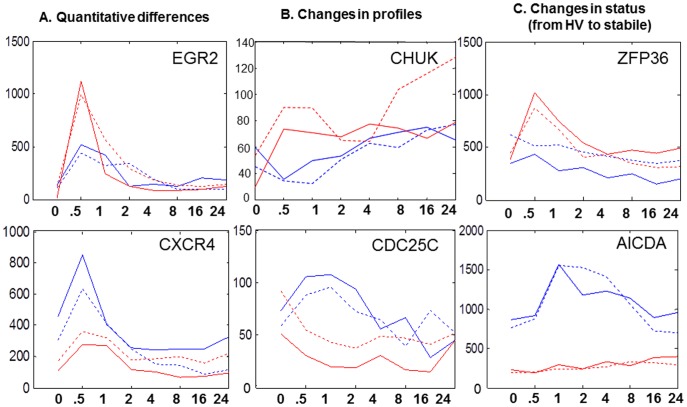
Differences in gene dynamics between normal control SLE samples.The shown profiles are representative of gene dynamics observed in duplicated experiments. Three differences in gene dynamics are shown: quantitative differences (left), changes in gene profiles (middle), and changes from hyper variable to stable (right). Graphs were shown as hours after stimulation (x-axis) and normalized gene expressions (y-axis). Each line on the graph represents one cell line. Each cell line was classified as a high responder (solid line) or low responder (hatched line). SLE patient sample gene expression is shown in red; while normal control sample gene expression is shown in blue.